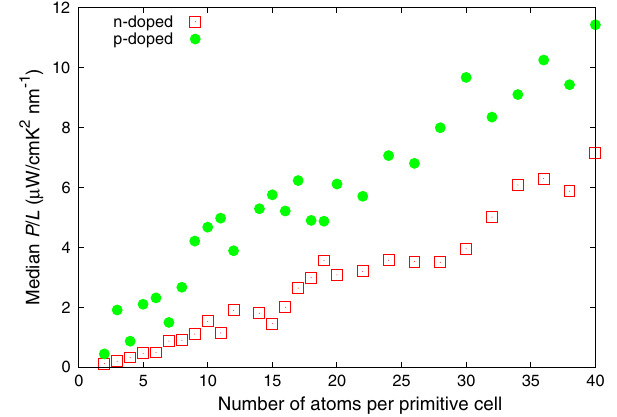
FIG. 2. Median of normalized power factors by grain size versus number of atoms per primitive cell for n-doped com- pounds (red squares) and p-doped compounds (green dots). High P correlates with the number of atoms per